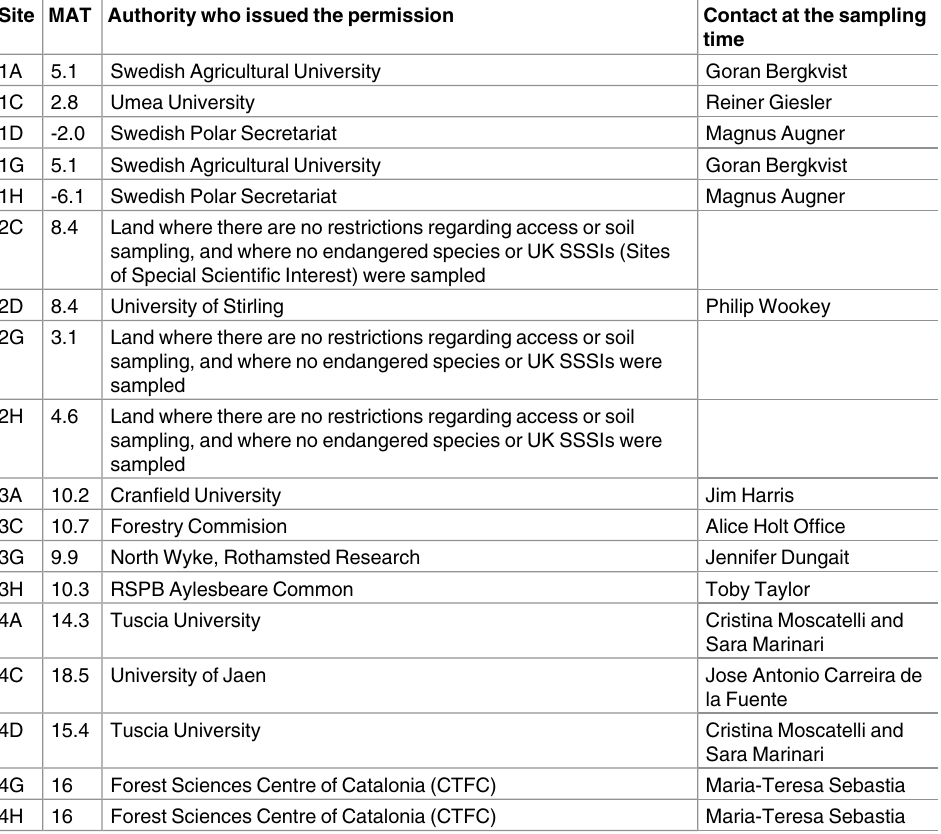
Table 1. Authorities who issued the permission for soil